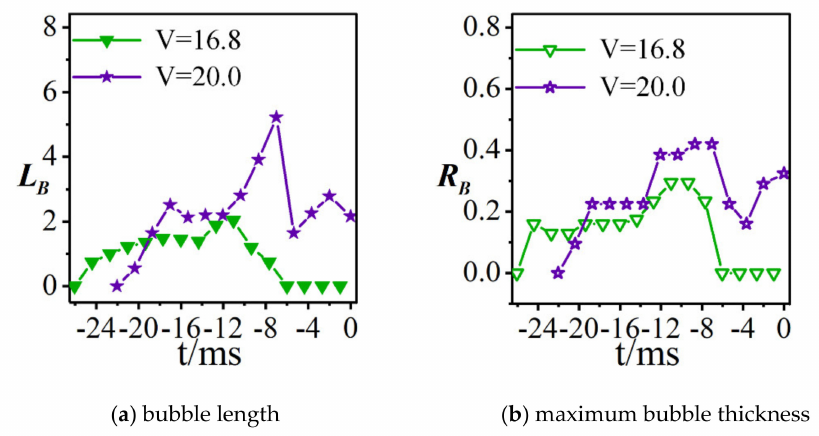
Figure 10. Variation curve of bubble sizes of hemispherical head projectiles at 16.8 m/s and 20.0 m/s.